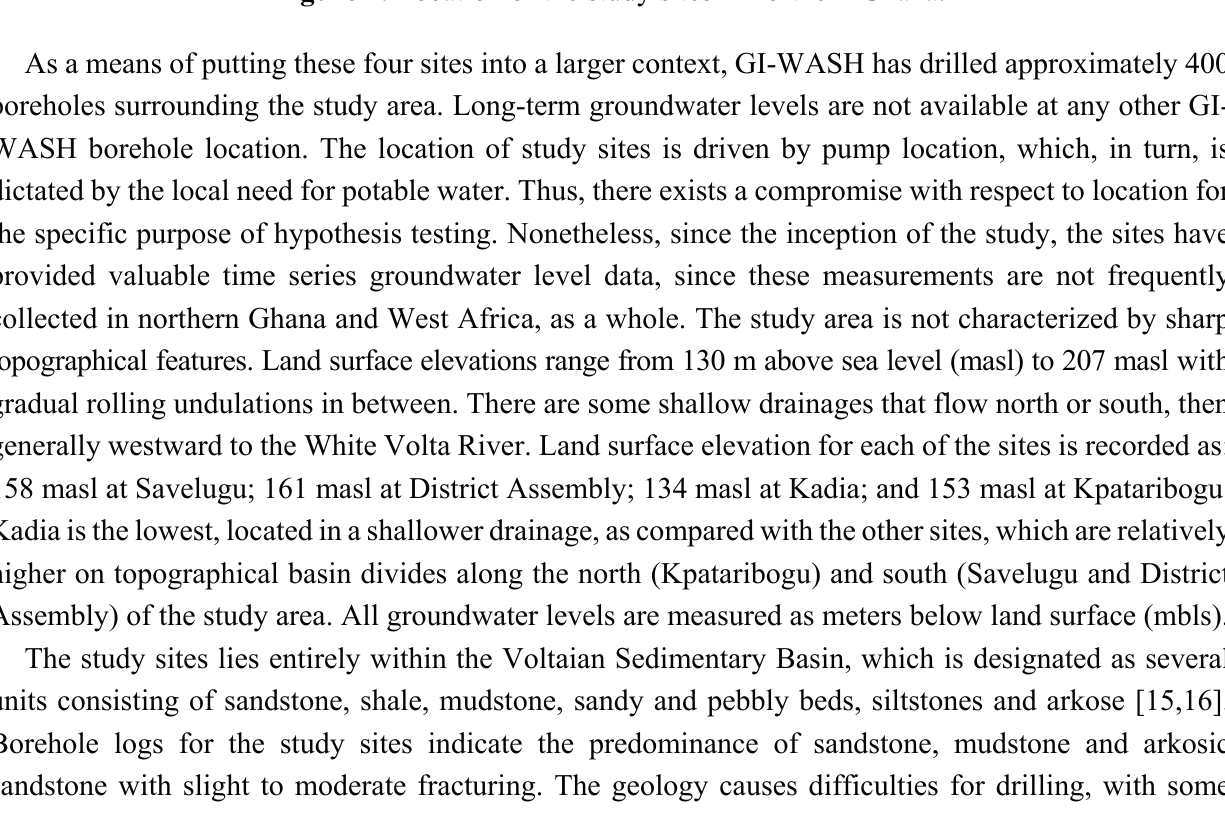
Figure 1. Location of the study sites in northern